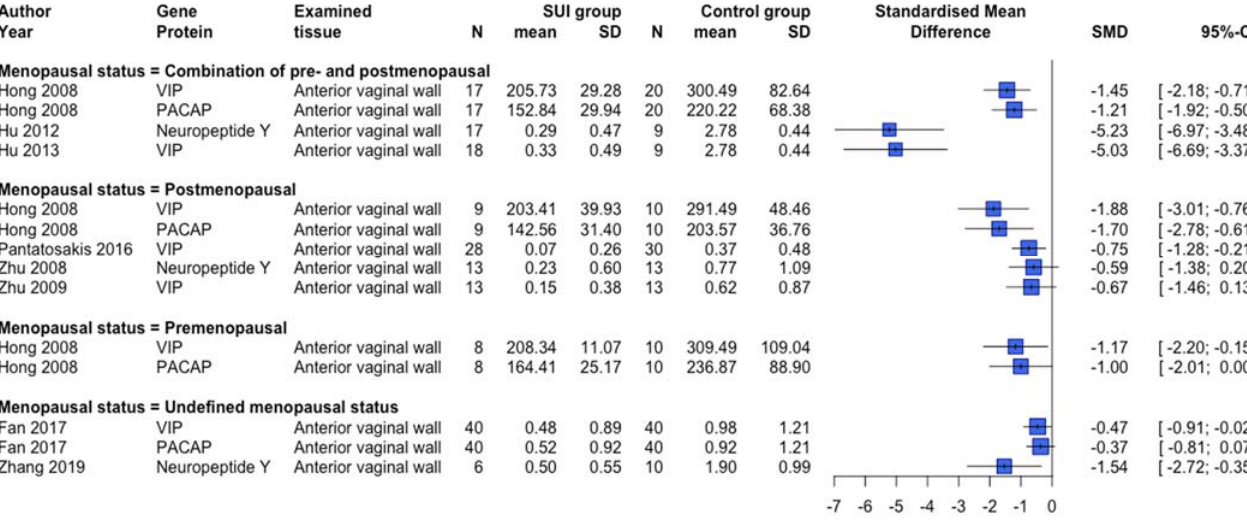
Figure 9. Forest plot of neuron-specific marker-related protein expression in human studies. This forest plot shows differences in the protein expression of neuron-specific markers between patients with SUI and controls, subdivided per menopausal status group. Abbreviations: CI confidence interval, N number, SD standard deviation, SMD standardized mean difference, SUI stress urinary incontinence.